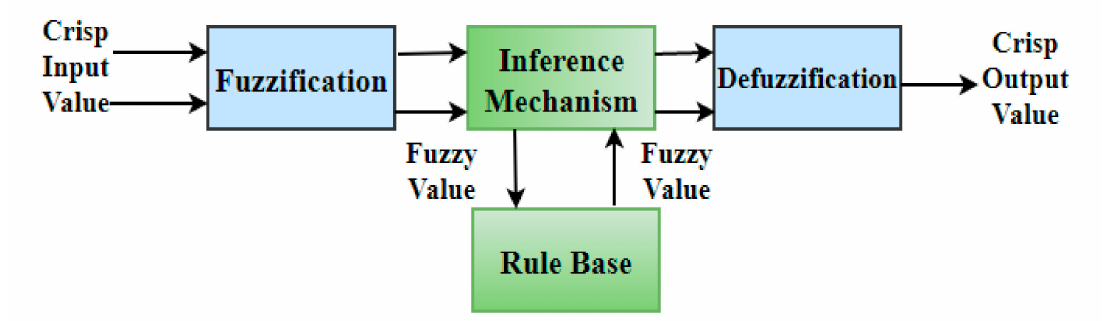
Figure 6. Basic block diagram of